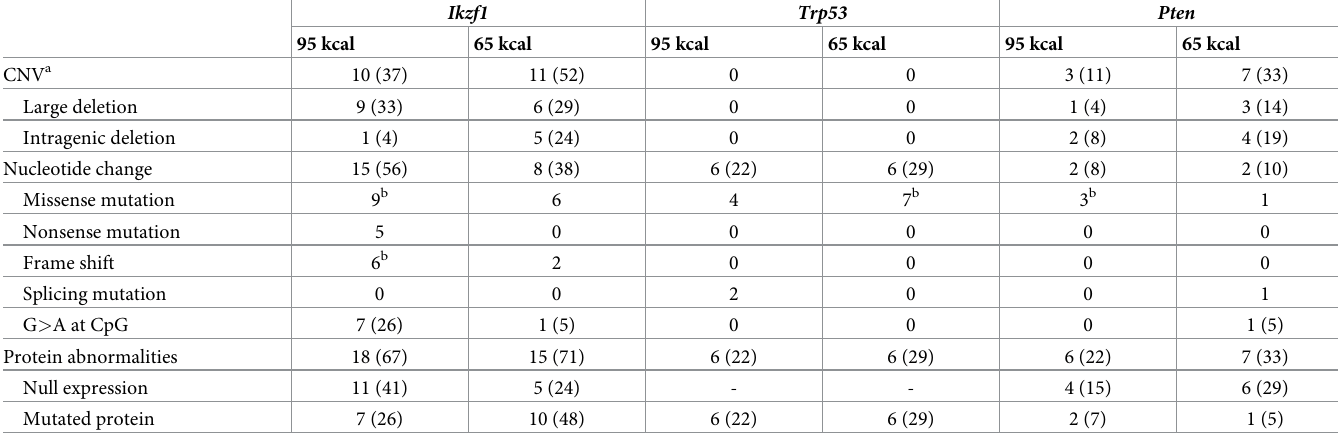
Table 2. TLs harboring mutations and protein abnormalities related to Ikzf1 , Trp53 , and Pten